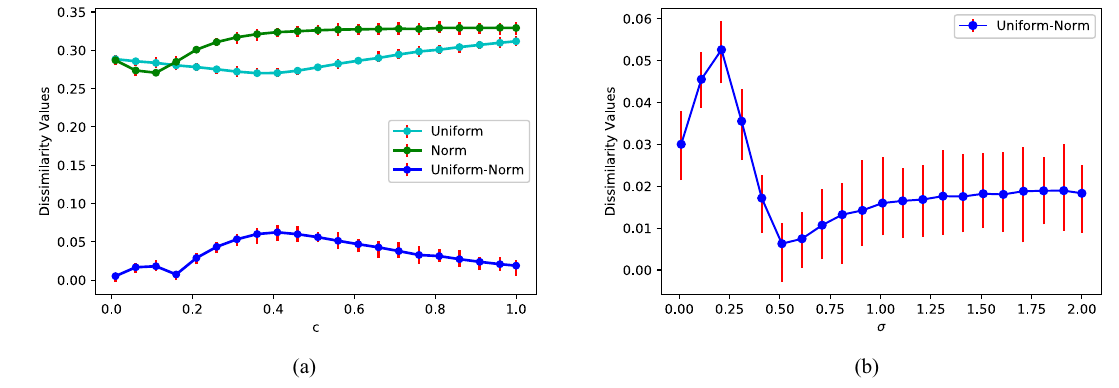
Figure 2. Comparisons between weighted complete graphs. ( a ) The cyan and the green lines depict the differences between weighted complete graphs and its binary counterpart, weights drawn from the uniform distribution U [ 1 − c , 1 + c ] and the normal distribution N ( 1, σ 2 ) , (σ = 2 c ) , respectively. The blue line depicts the difference of two weighted networks with the weights drawn from U [ 1 − c , 1 + c ] and N ( 1, σ 2 ) , (σ = 2 c ) . ( b ) The differences of two weighted networks with the weights drawn from U [0, 2] and N ( 1, σ 2 ) change with σ .